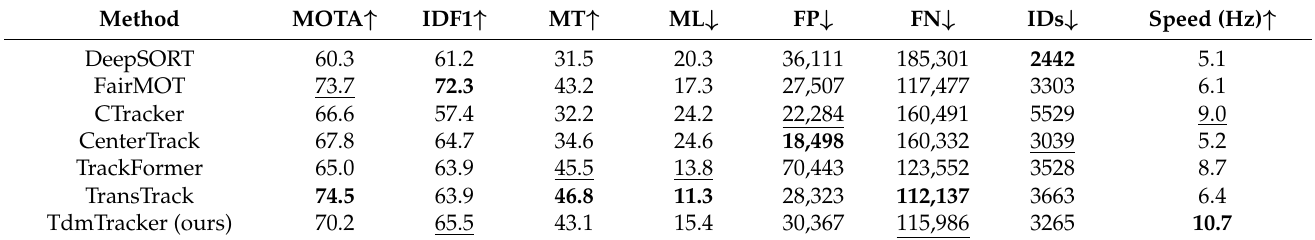
Table 1. Performance comparison of our proposed model with other state-of-the-art MOT methods. ↓ means the smaller the better; ↑ means the larger the better. In each column, the best result is in bold , and the second best is